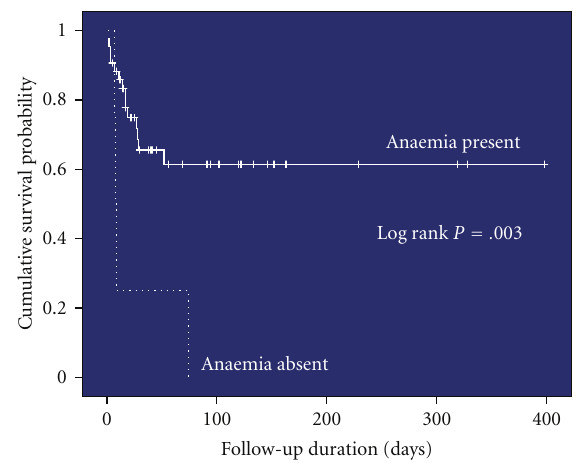
Figure 4: Kaplan-Meier survival curves comparing survival in cardiorenal syndrome patients with anaemia and those without anaemia. Patients with anaemia had significantly higher survival rate compared to nonanaemic patients (61.4% versus 25.0%).